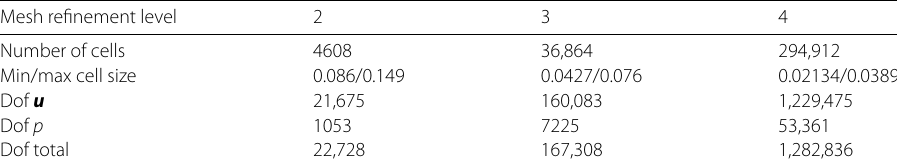
Table 2 Mesh parameters. The abbreviation “Dof” refers to the number of degrees of freedom Mesh refinement level 2 3 4 Number of cells